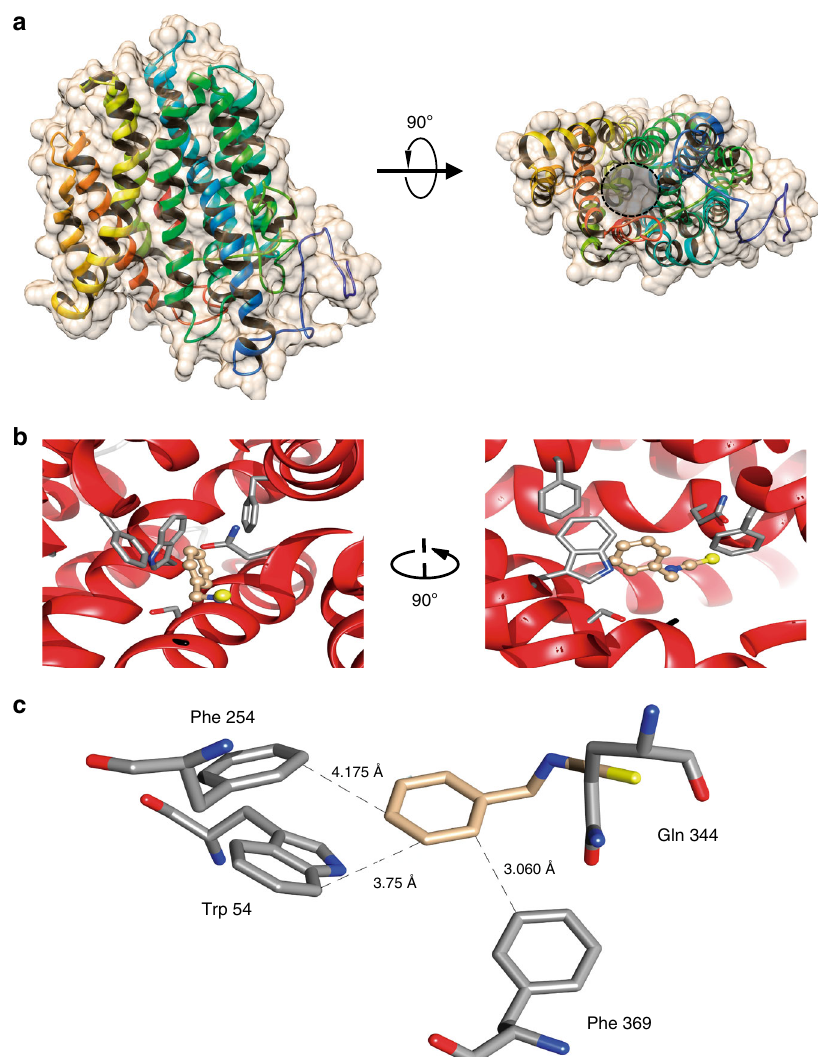
Fig. 7 MFS motif tertiary structure and docking analysis of B. cinerea mfsG . a MFS tertiary structure viewed from the side of the membrane, and rotated through 90°; the conserved 12 transmembrane (TM) α -helix fold is arranged into two 6 TM helix bundles forming a cavity (marked with dashed circle) at the interface between them that is accessible to either the cytoplasm or extracellular region, depending on the conformational state. b Molecular docking between BITC molecule and MFS revealed a putative binding site formed by residues located in the internal channel of MFS. The proposed binding region is formed by the aromatic rings of residues Trp54, Phe254, Gln344, and Phe369. c Distances were measured between the BITC molecule and side chains of these residues, where the biggest distance was 4.175 Å with